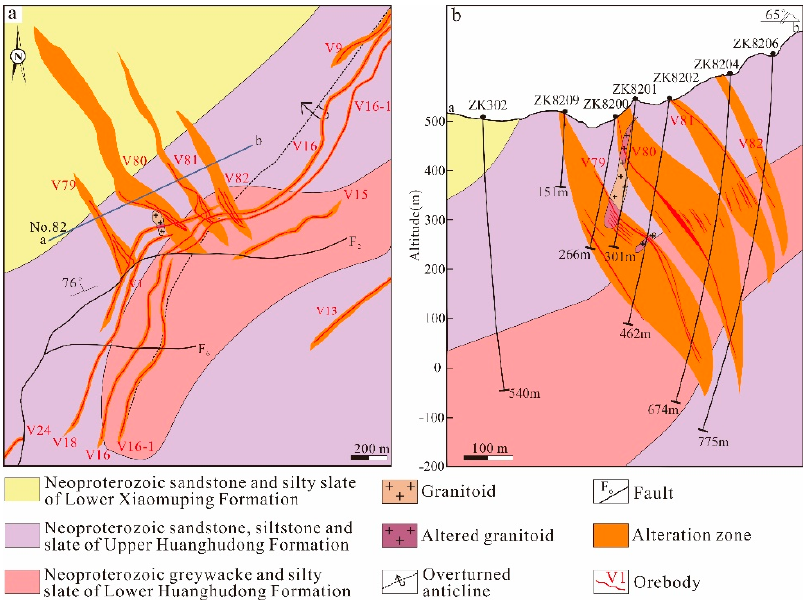
Figure 2. ( a ) Simplified geological map of Zhengchong gold deposit showing the major host rocks, orebodies and alteration zones; ( b ) Profile of the No. 82 cross section of the Zhengchong gold deposit.